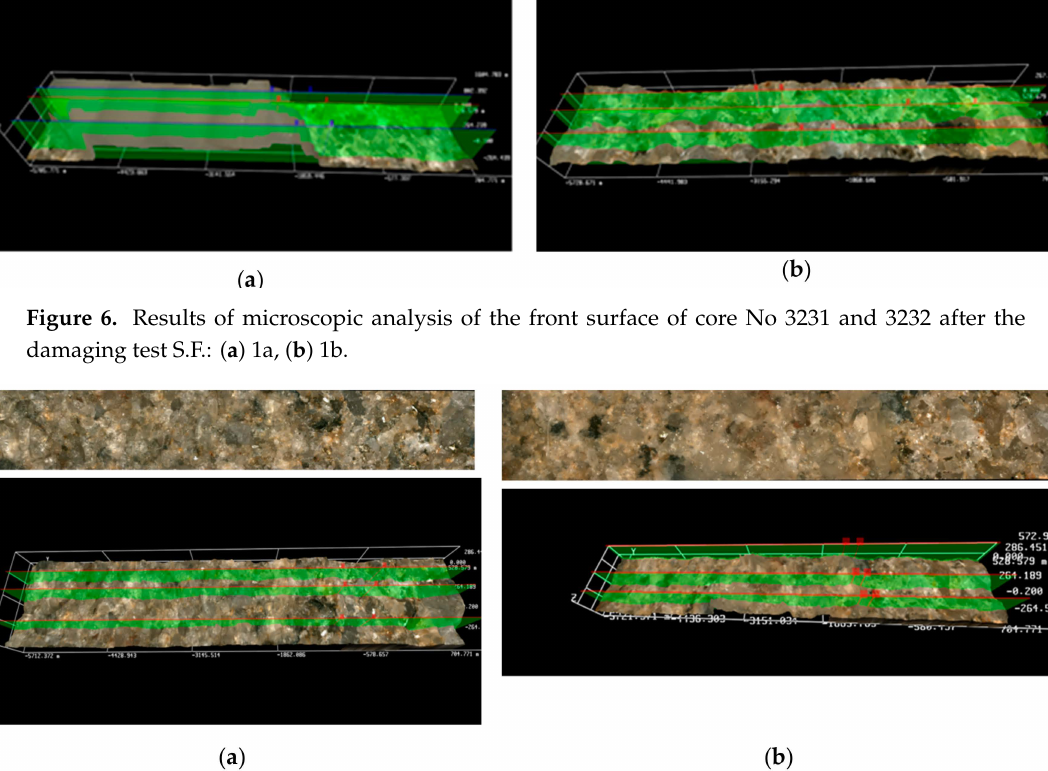
Figure 7. Results of microscopic analysis of the front surface of core No 3226 and 3224 after the damaging test S.F.: ( a ) 2a, ( b )